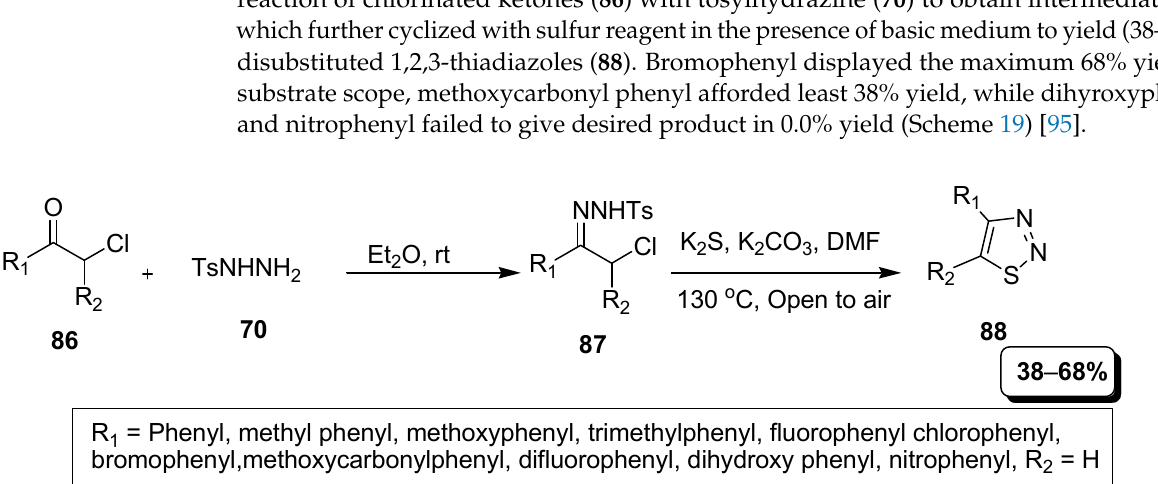
•− via a cascade 3